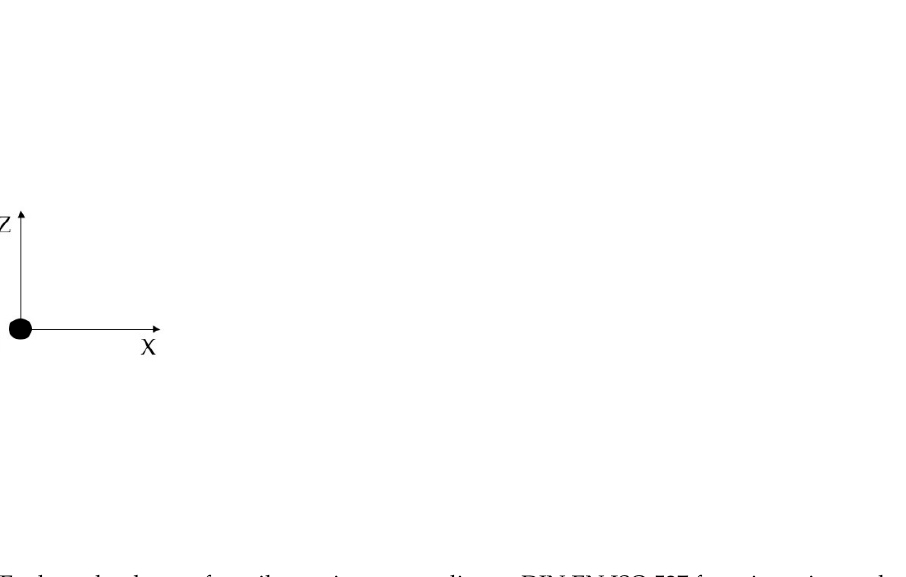
Figure 1. Evaluated volume of tensile specimen according to DIN EN ISO 527 for orientation and length of glass fi ber.